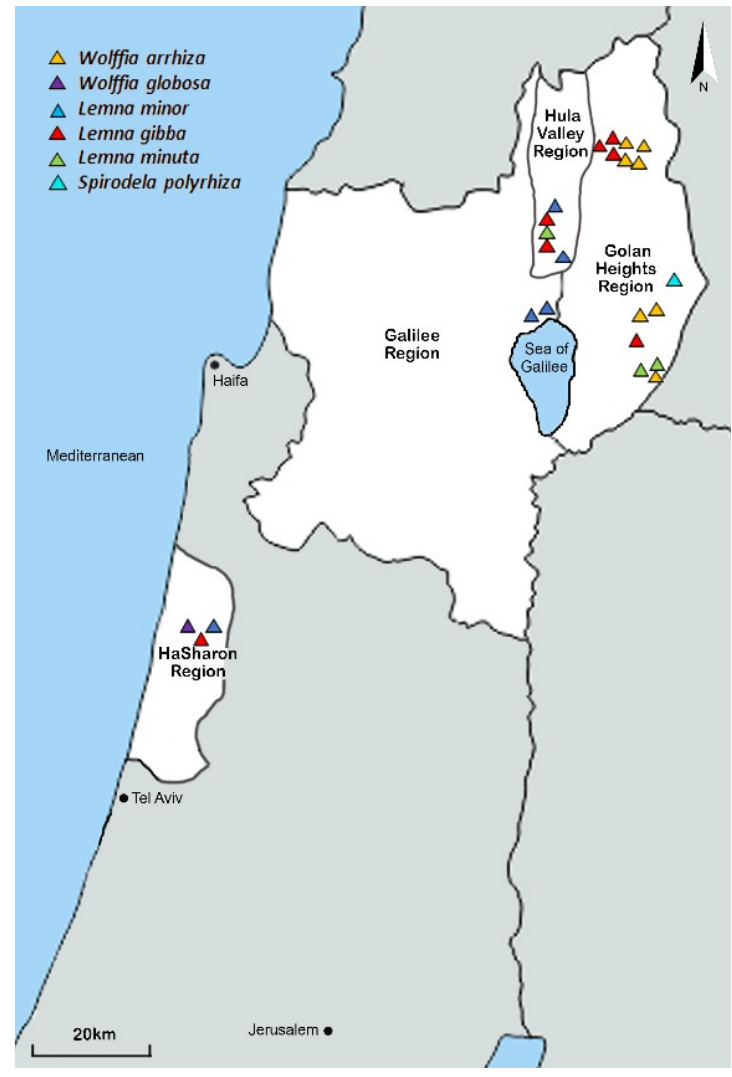
Figure 1. Confirmed duckweed sightings in northern and central Israel. White paint indicates the areas where the survey was conducted. Scale bar is 1:20,000.